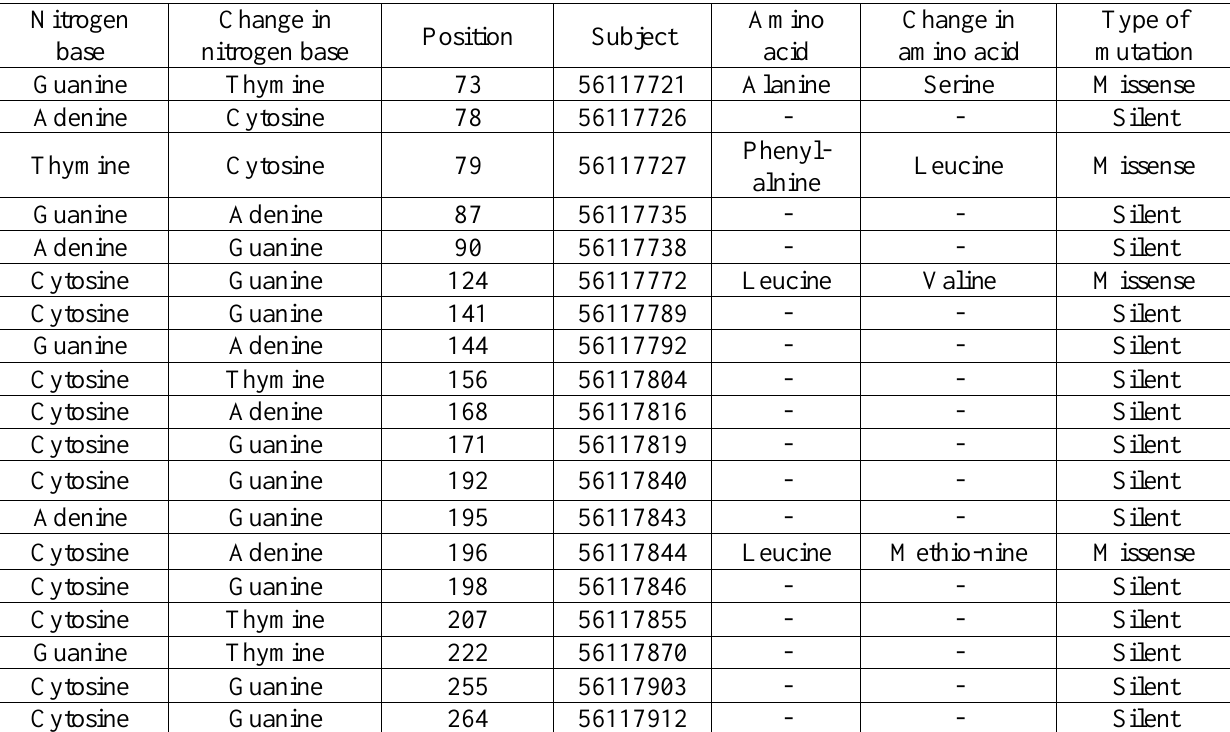
Table (2): Changes in Nitrogenous Bases and Their Effect on Translating Amino Acid of the QacE gene for Ps-3 Isolate of P.